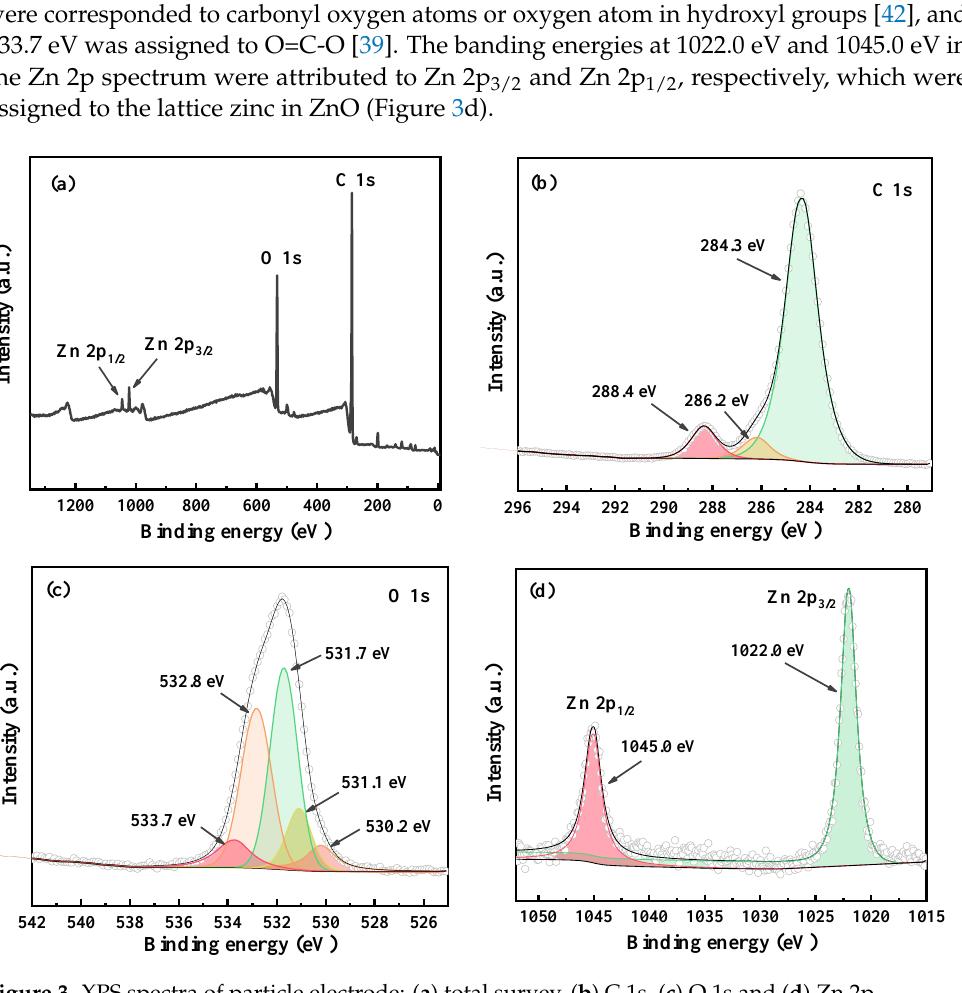
Figure 3. XPS spectra of particle electrode: ( a ) total survey, ( b ) C 1s, ( c ) O 1s and ( d ) Zn 2p.